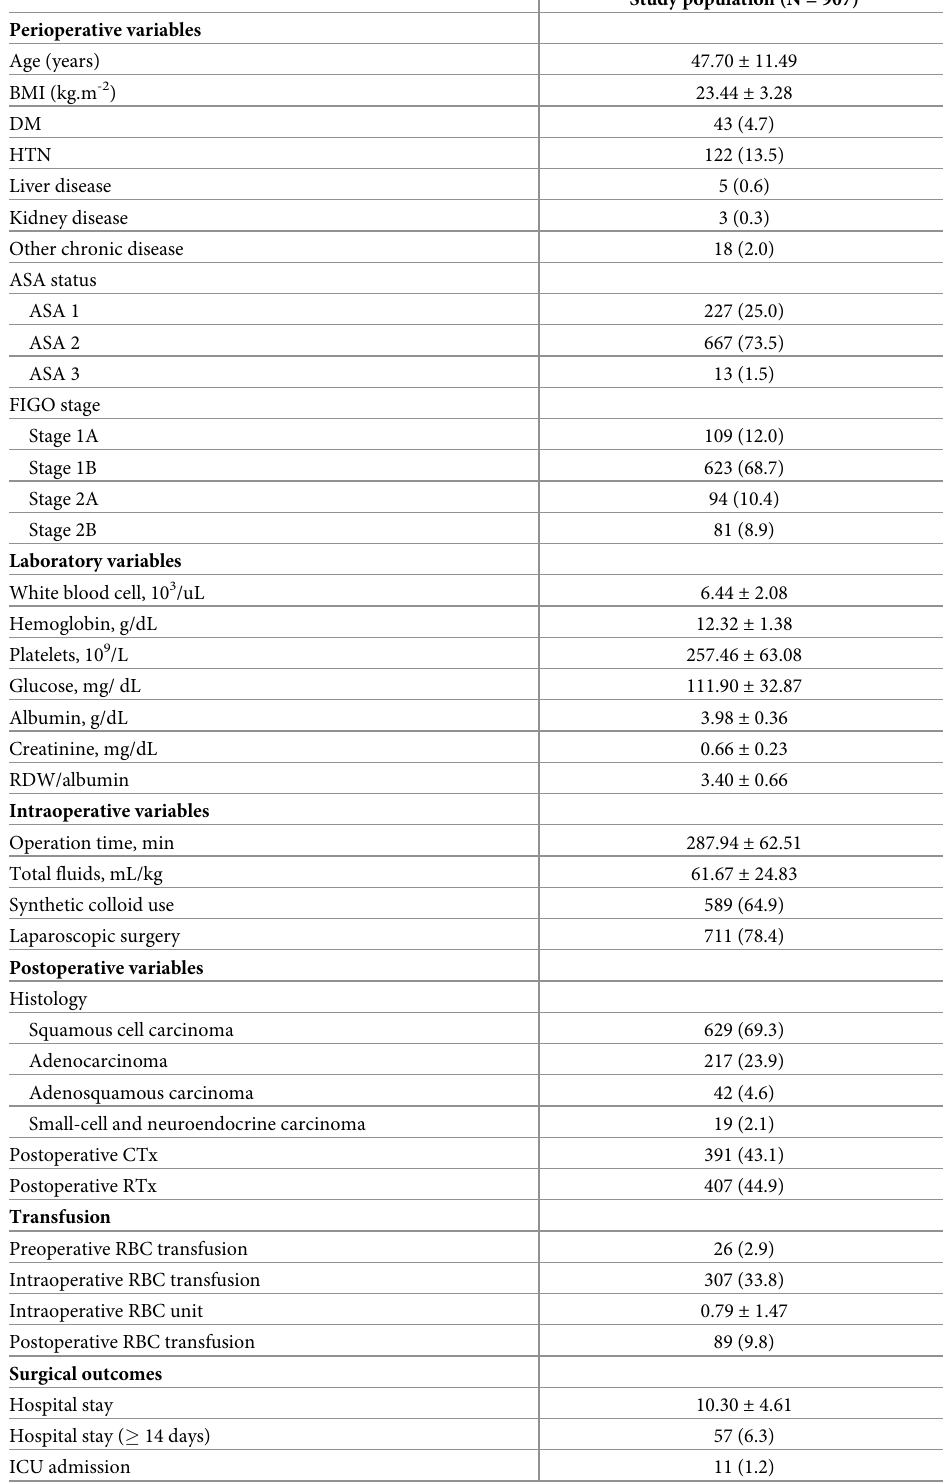
Table 1. Demographic data and perioperative variables of the study